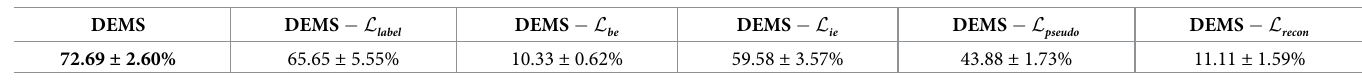
Table 6. Ablation study on MNIST-M target dataset. DEMS